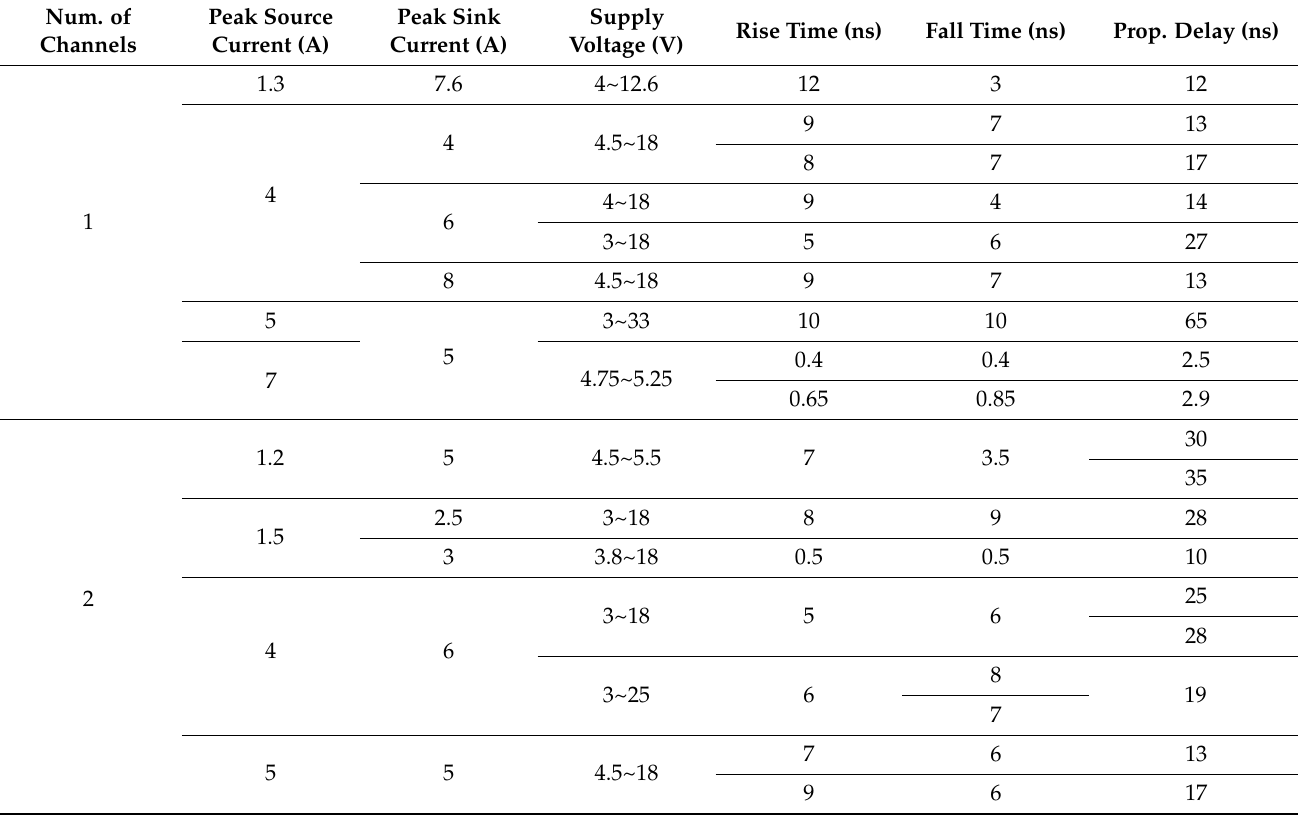
Table 25. Commercial GaN HEMT drivers by Texas Instruments.